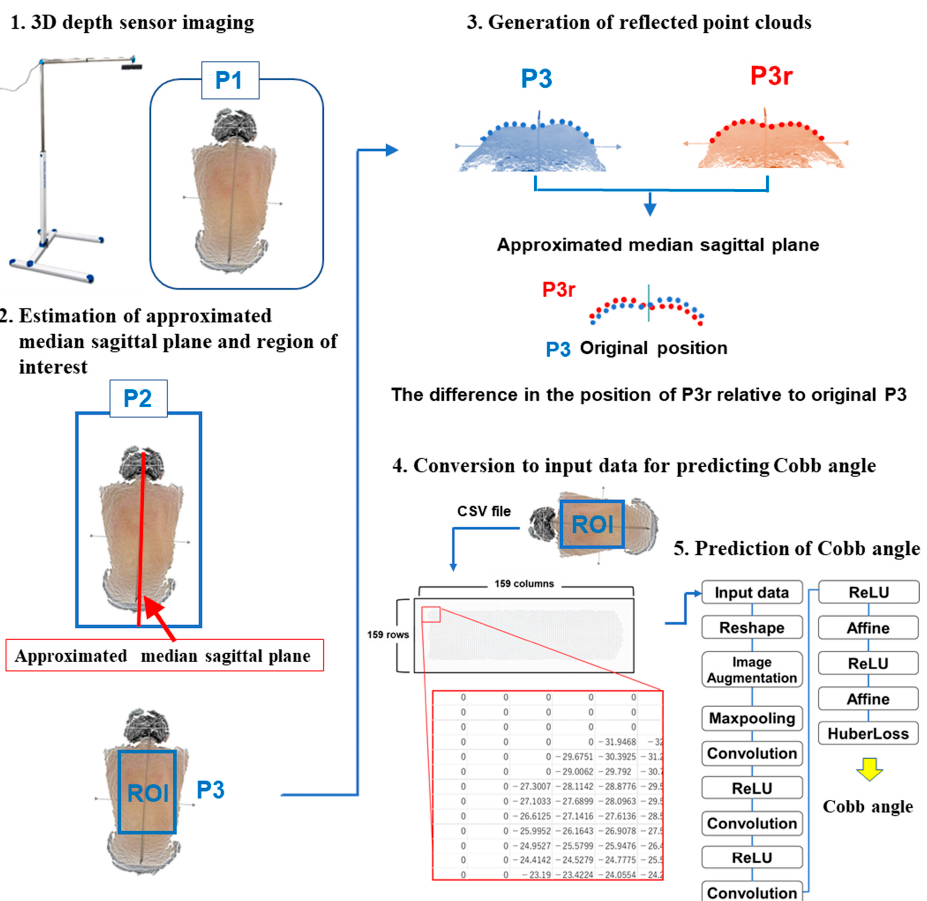
Figure 1. Previously developed algorithm [4–6] to obtain input data used in the deep learning algorithm for prediction of Cobb angle. The comma-separated value (CSV) files were generated by converting from the point clouds within the region of interest. The CSV files included 159 rows and 159 columns, where zeros were filled into boxes without a number.